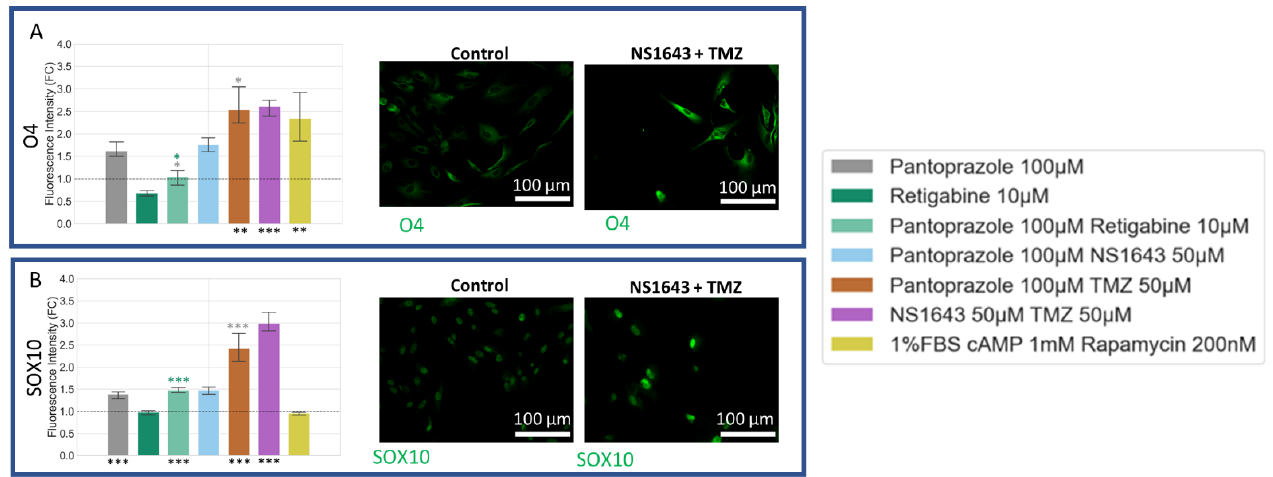
Figure 13. Differentiation Analysis of U87 Cells Reveals that Treatments with Pantoprazole Increased Oligodendrocyte Markers after 6 days. Immunofluorescence of cells was conducted and analyzed with CellProfiler for integrated fluorescence intensity. ( A ) Stain of oligodendrocyte marker O4. ( B ) Stain of the Sry-related HMg-Box gene 10 (SOX10). Treatments corresponding to the colored bars are outlined in the figure itself. The log of the fold change in intensity was compared between single treatments and combined treatments, except the positive control, with significant values shown in the color of the treatment compared. The initial fluorescence intensities were compared to their corresponding control, with significant values shown under the bars as, ***: p < 0.001, **: p < 0.01, * : p < 0.05 (one-way ANOVA with Tukey post hoc analysis n > 3 technical replicates).